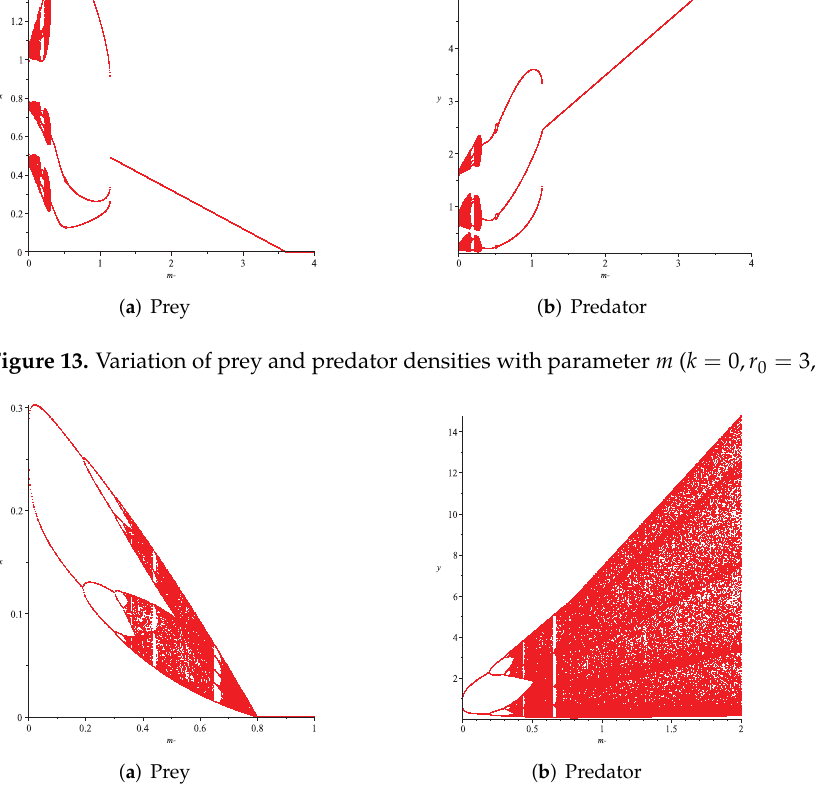
Figure 14. Variation of prey and predator densities with parameter m ( k = 0, r 0 = 1.5, h =